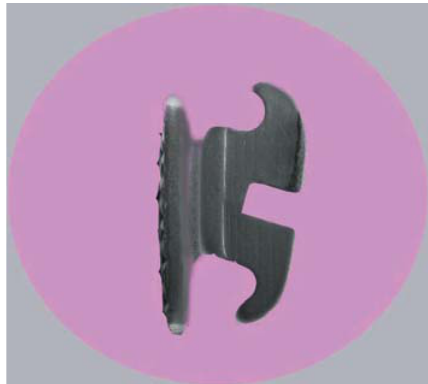
Figure 1- Fixation of the brackets in the template